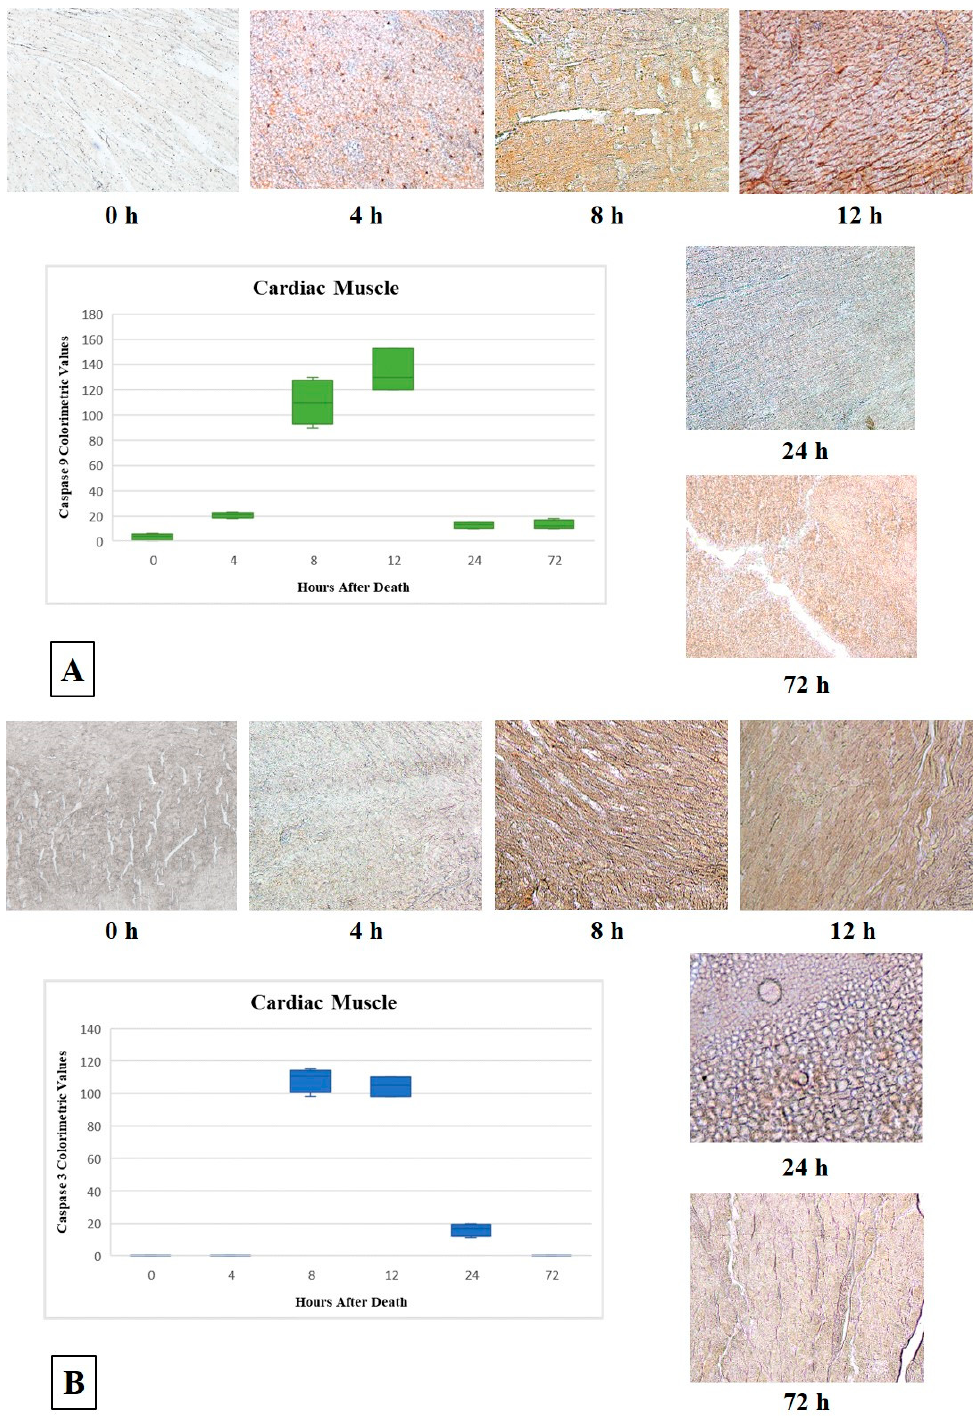
Figure 3. Graphs (boxplot) showing the median, minimum, and maximum of Caspase 9 and Caspase 3 expression (respectively ( A , B )) in cardiac muscle at each PMI group and related repre- sentative images on immunopositivity observed at the designated time of PMI ((Caspase 9—0 h: 10×; 4 h: 10×; 8 h: 10×; 12 h: 10×; 24 h: 10×; 72 h: 10×. Caspase 3—0 h: 10×; 4 h: 10×; 8 h: 10×; 12 h: 10×; 24 h: 10×; 72 h: 10×). 24 h: 10 × ; 72 h: 10 ×